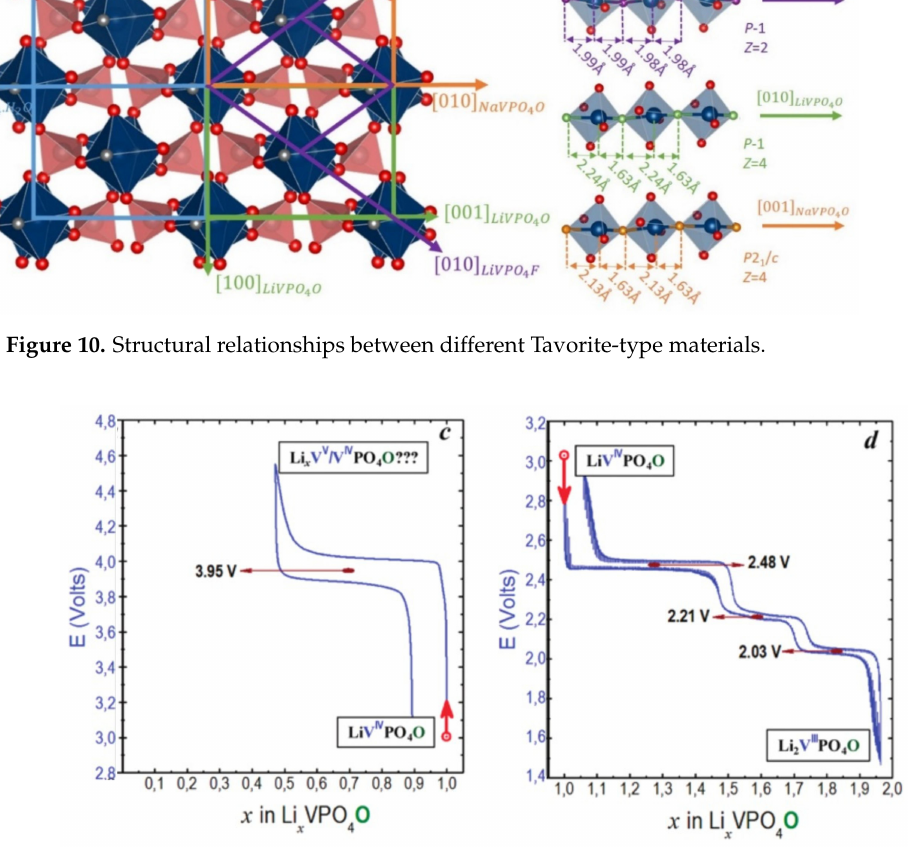
Figure 11. Voltage profile of Li x VPO 4 O cycled between 3.0–4.6 V vs. Li + /Li ( left ) and between 3.0 and 1.5 V vs. Li + /Li in GITT mode ( right ) adapted from ref. [14]. Reproduced with permission from Ateba Mba et al., Chemistry of Materials; published by American Chemical Society,